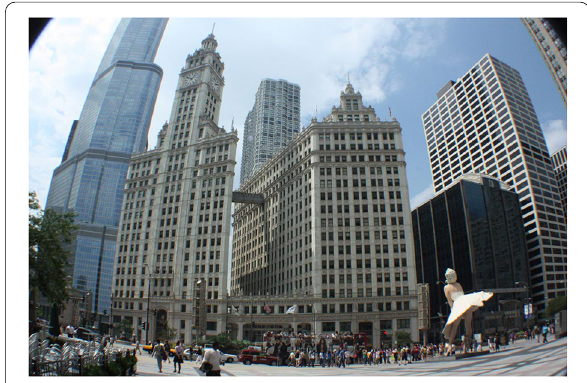
Fig. 4 A sculpture of Marilyn Monroe in downtown Chicago. The urban model of Hollywood